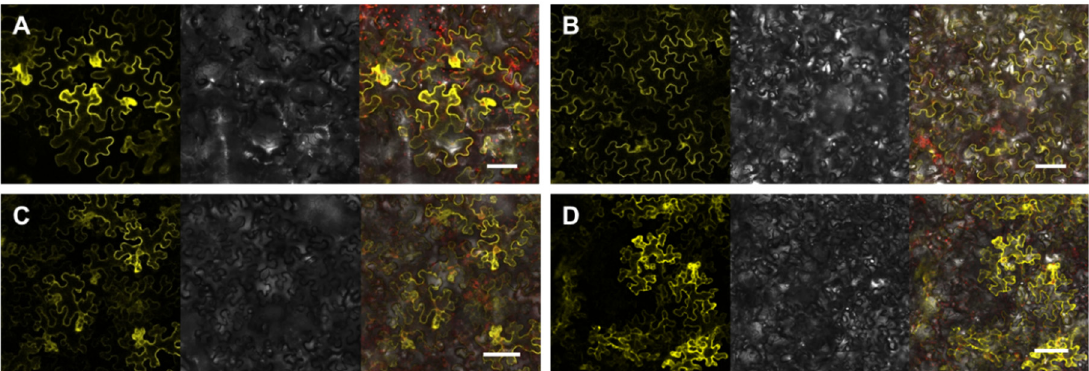
Figure 2. Bimolecular fluorescence complementation analysis in N. benthamiana . Plasmids containing the generated yfp NT and yfp CT constructs were transiently co-transformed into N. benthamiana leaves using A. tumefaciens mediated transformation. Left image: YFP fluorescence, middle image: transmitted light and right image: merge of YFP fluorescence, chlorophyll fluorescence and transmitted light. The YFP fluorescence signal was detected using a Leica TCS SP5II confocal laser scanning microscope system. Bar = 100 µm. ( A ) 14-3-3 υ ::yfp CTT and sos1C-term::yfp NT . ( B ) 14-3-3 ω ::yfp CT